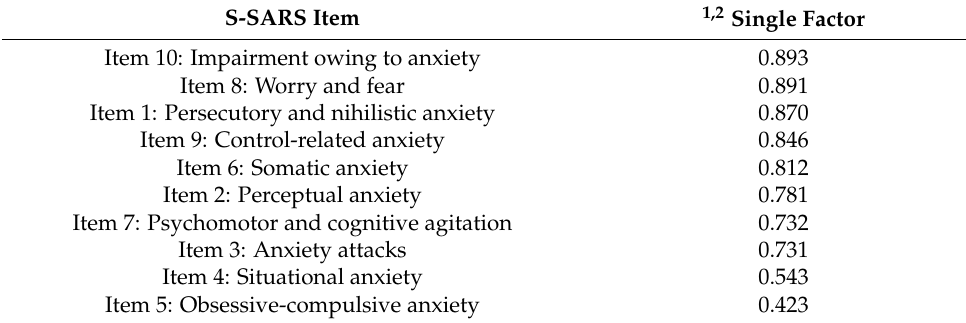
Table 10. Factor matrix of the S-SARS items derived from a factor analysis ( n =